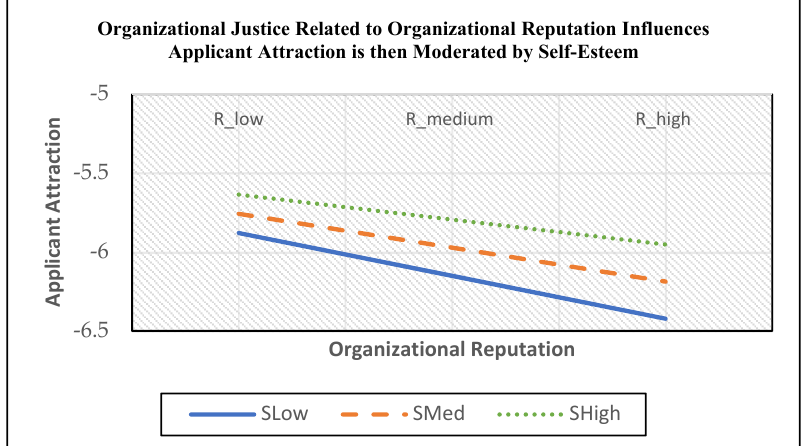
Figure 2. Moderated Mediation Interaction of Organizational Justice.